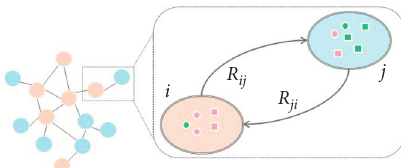
Figure 1: Illustration of financial risk information spreading on metapopulation network. Orange and blue circles represent the depressing subpopulation ( DS ) and active subpopulation ( AS ) , respectively. Green and blue circles stand for the unaware and aware individuals. The directed edges R ij means the preference travelling probability from subpopulation i to j